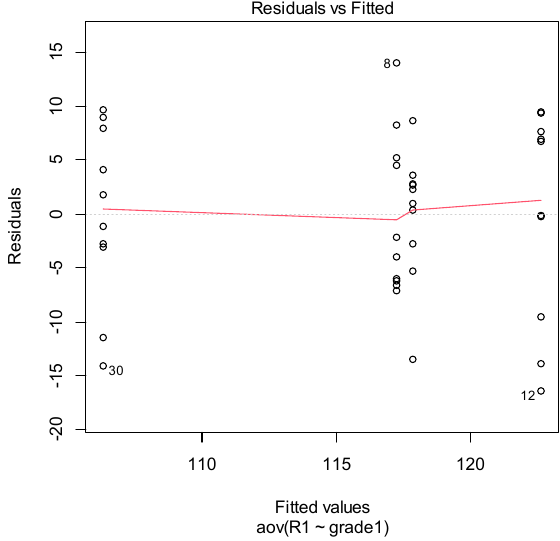
Figure 7. Residuals vs. fitted from ANOVA in NETXDENT material case.